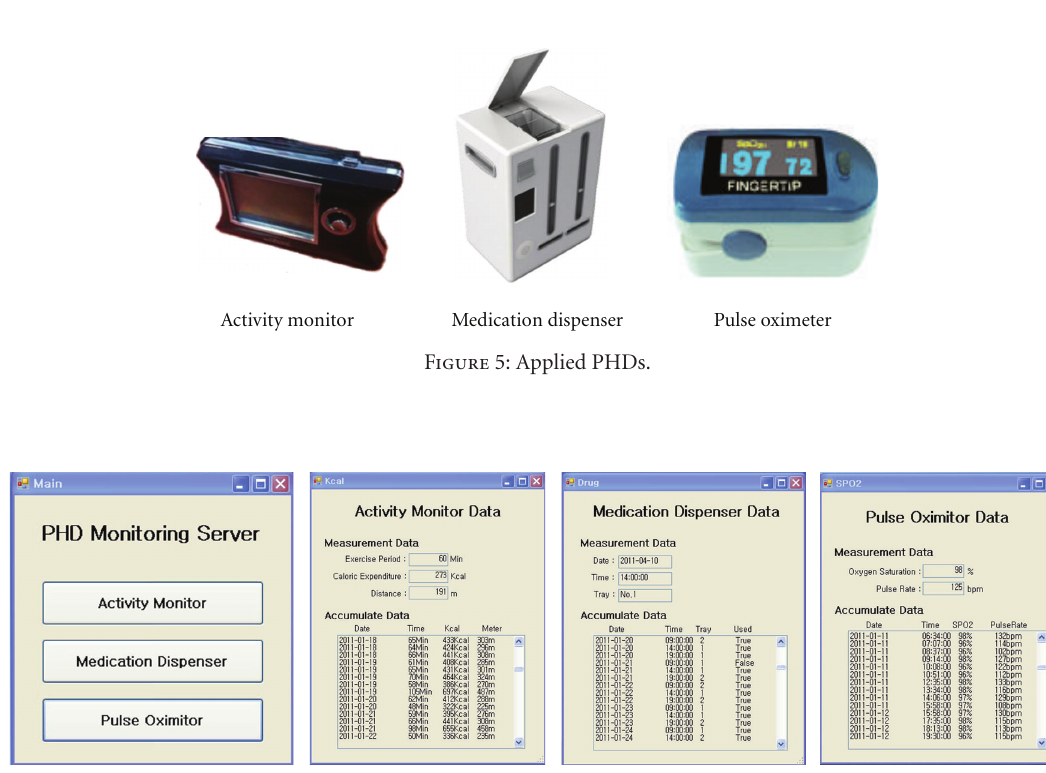
Figure 6: Graphical UI of